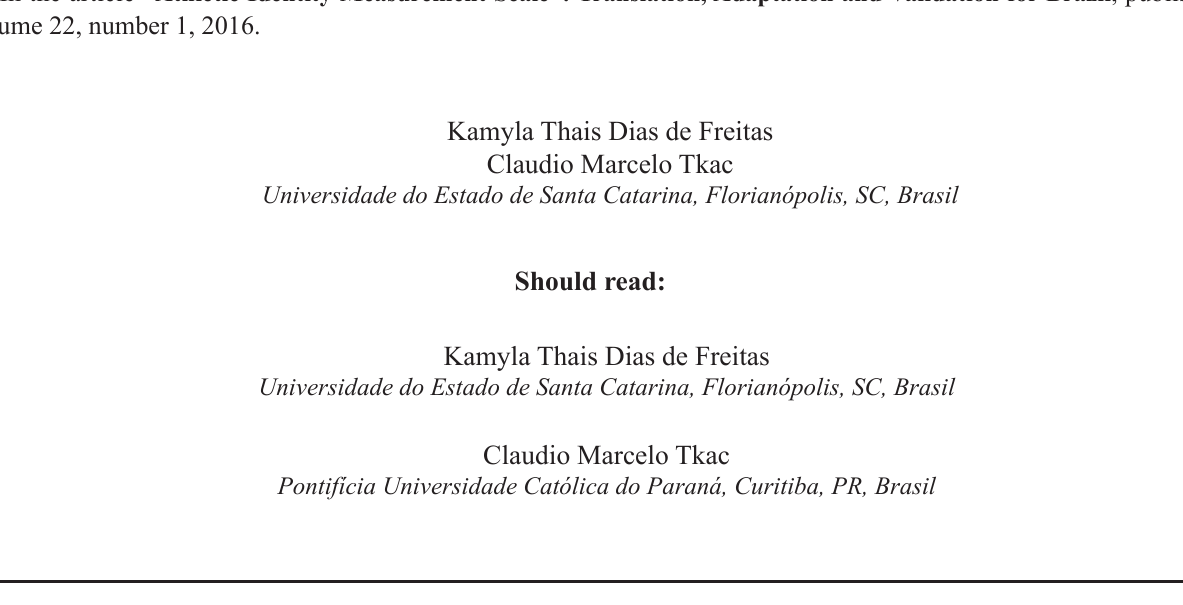
page 56, second column, lines 30-31: “Ventilatory Threshold2” and “Ventilatory Threshold2 (VT2)” should read